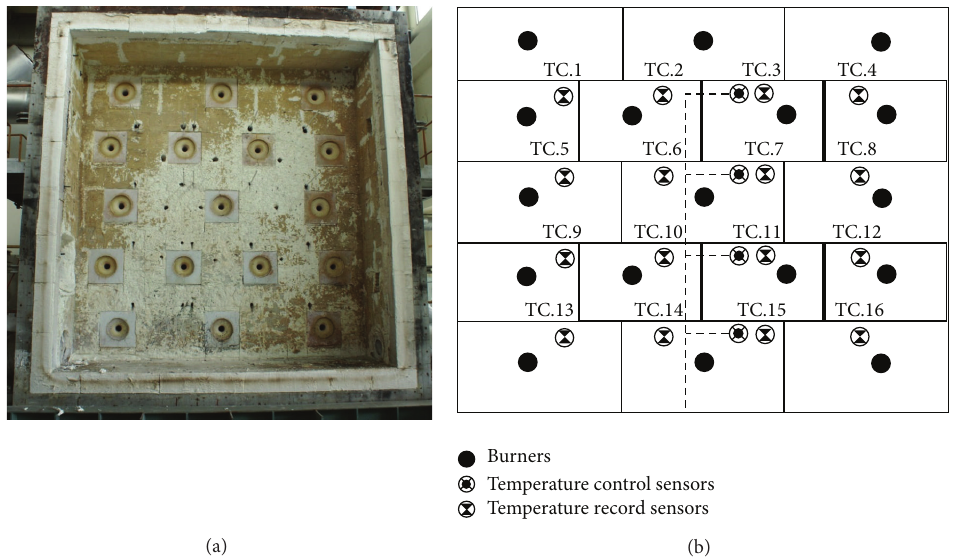
Figure 1: (a) Full-scale heating furnace; (b) positions of thermocouples inside the full-scale heating furnace.